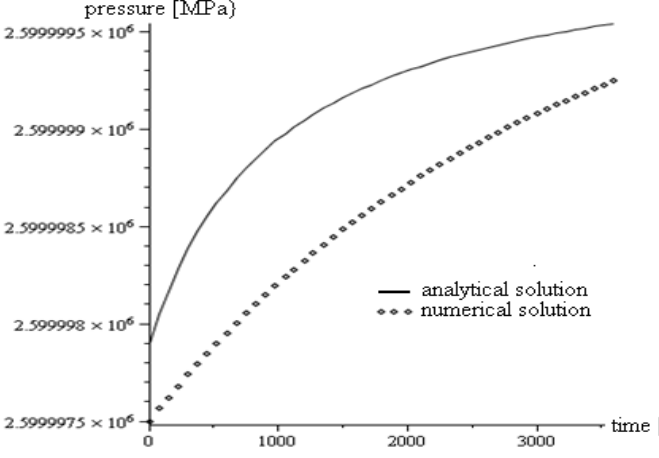
Figure 2. Comparison of semi-analytical and numerical solutions for the same data. The difference between the two types of solutions is due to the inherent limitations of the semi-analytical solution. The numerical solution is able to provide more information regarding the entities involved in the problem considered, while the semi-analytical solution, which is faster, is necessary for validating the numerical calculation [4].